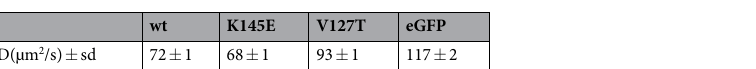
Fluor. Form Ex/Em, nm Φ ± s.d.